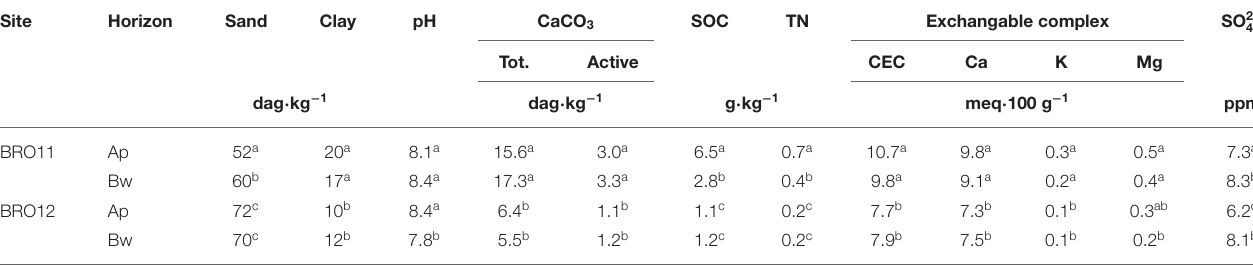
TABLE 1 | Main soil physical and chemical properties. Site Horizon Sand Clay pH CaCO 3 SOC TN Exchangable complex SO 2 − 4 Tot. Active CEC Ca K